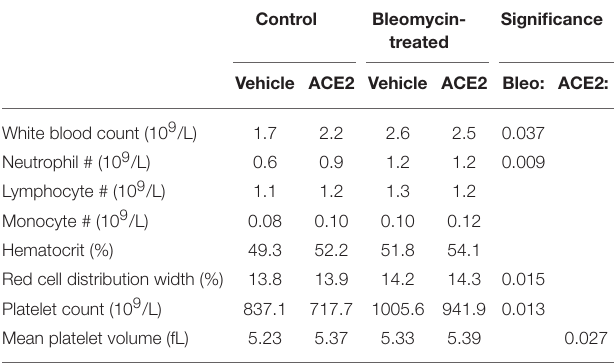
TABLE 2 | Results of complete blood count.